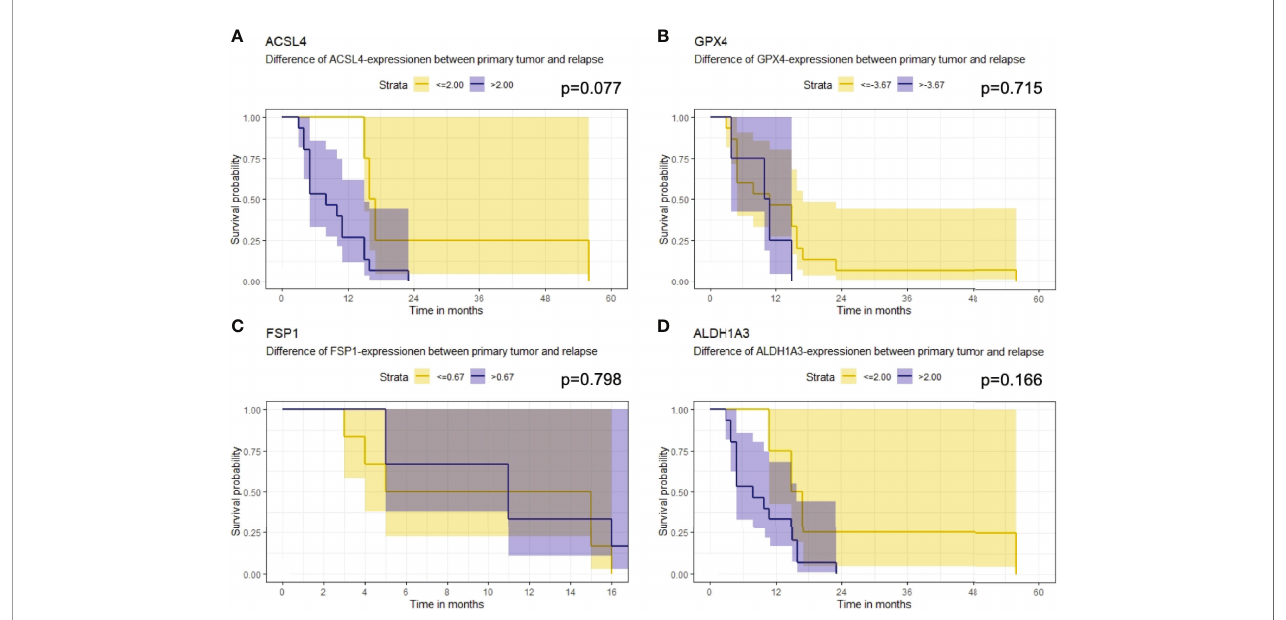
FIGURE 7 | Kaplan-Meier survival curves. Starting point for measurement of survival time was the time at recurrent con fi rmation. The p-value describes a possible association between enzyme expression and OS. (A) Patients whose ACSL4 expression increased by more than 2.00 IRS points had a worse outcome, although. (B) GPX4 cutpoint is at -3.67. Patients with a higher pronounced decrease in GPX4 expression had a slightly better outcome. (C) FSP1 cutpoint is at 0.67. There is no relevant association. (D) ALDH1A3 cutpoint is at 2.00. Patients with a higher increase had a worse outcome.